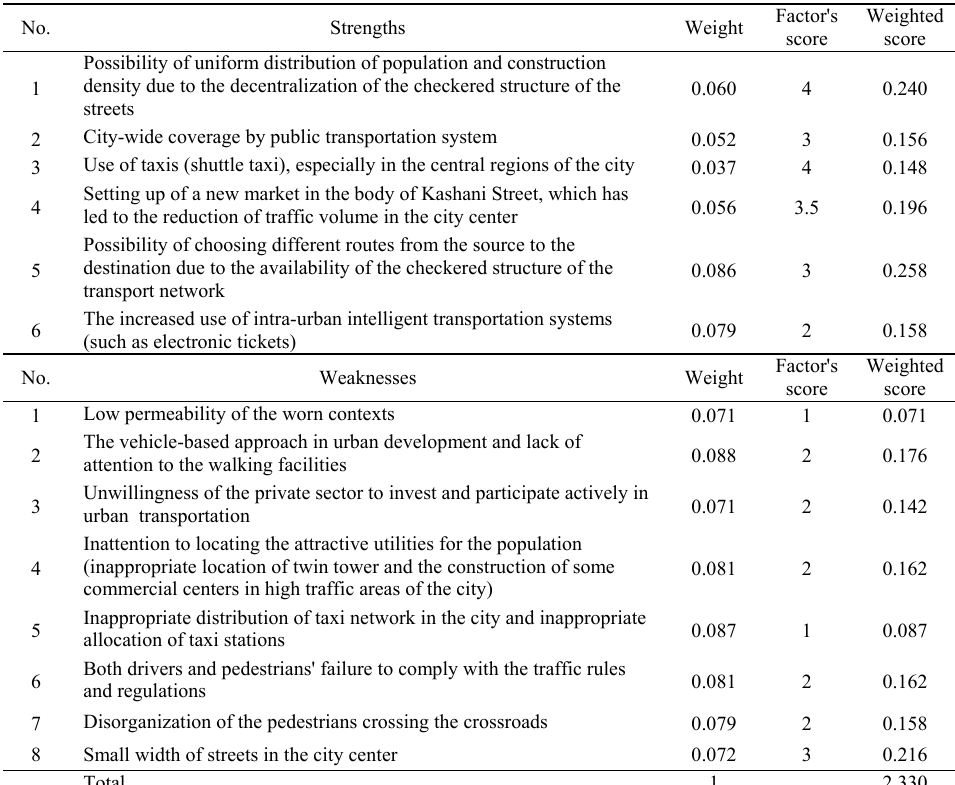
Table 3: Results of the analysis of internal factors (strengths and weaknesses)